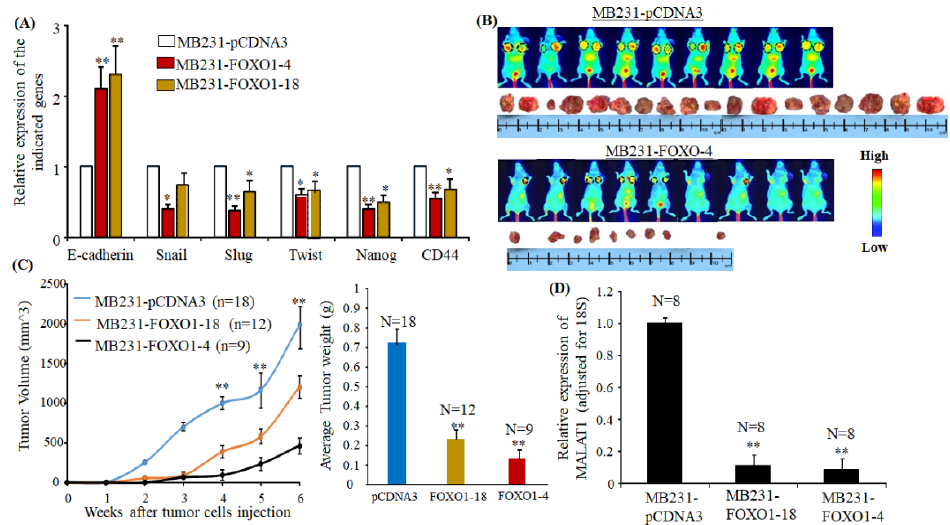
Figure 6. Overexpressing FOXO1 downregulates MALAT1 and inhibits tumor formation in vivo. ( A ). RT-qPCR was used to determine the expression of the indicated genes in MB231-pCDNA3, MB231-FOXO1-4, and MB231-FOXO1-18. The bar graph shows their expression levels adjusted for 18S. Each bar indicates a mean ± SEM from four repeated experiments. FOXO1transfection reversed EMT marker gene expression, * p < 0.05, and * * p < 0.01 compared to MB231-pCDNA3 transfection as